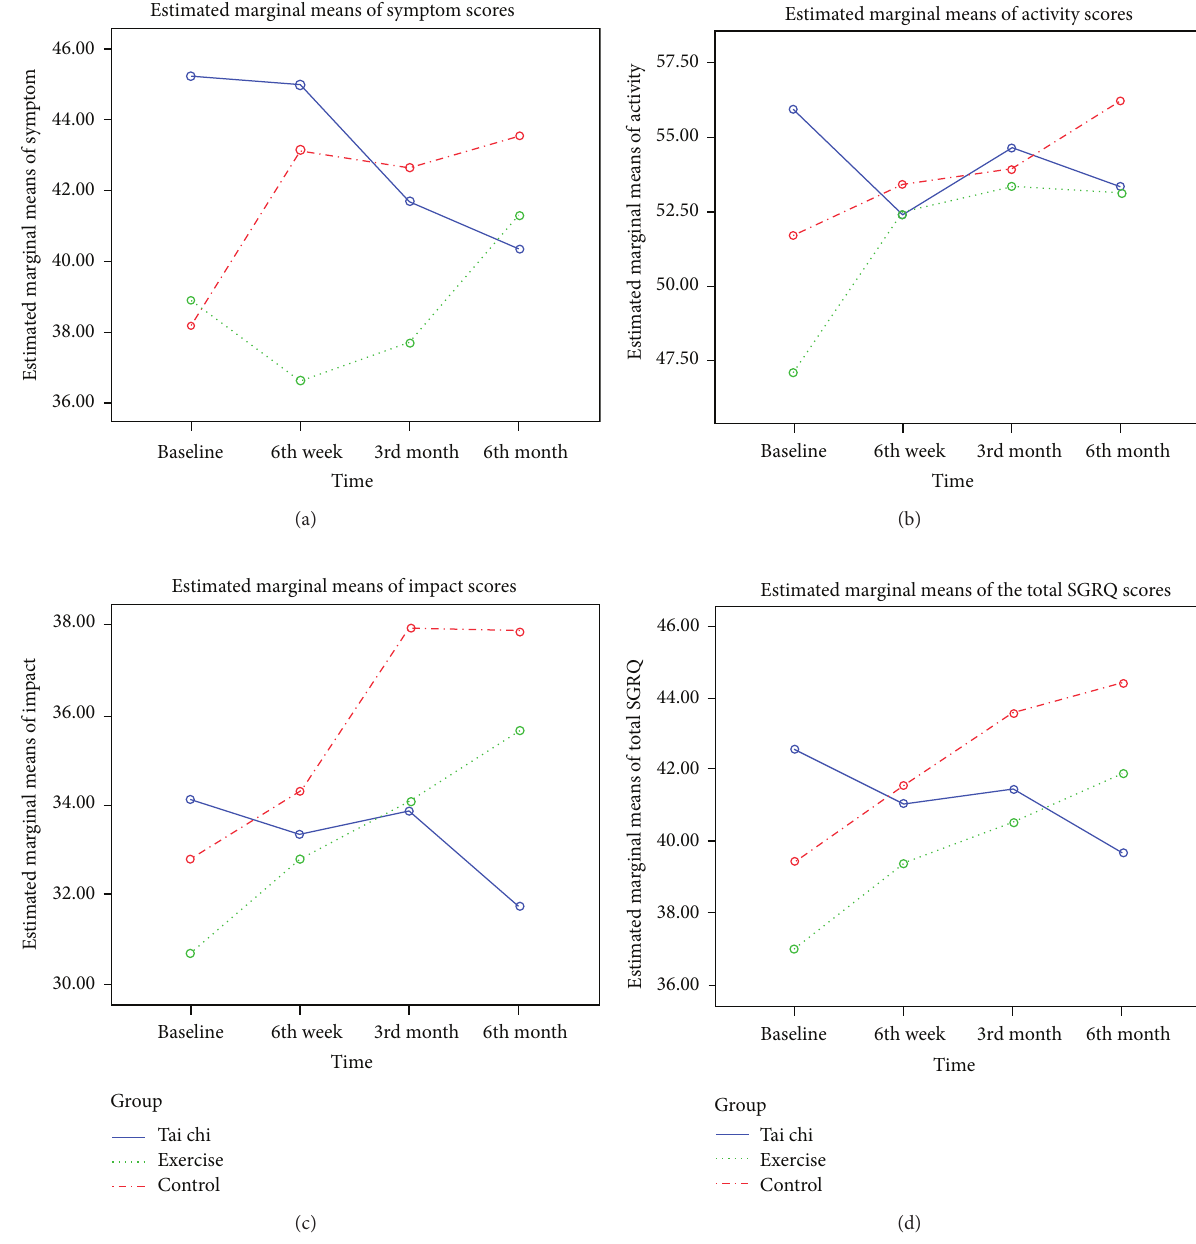
Figure 2: Mean scores of the four domains of St George’s respiratory questionnaire (SGRQ) among the three study groups from baseline to 6th